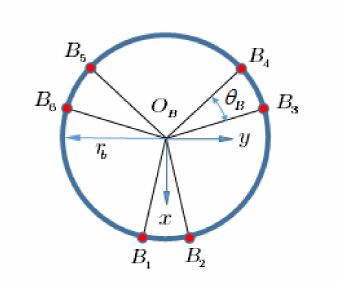
Figure 14. Specifications of the moving platform.